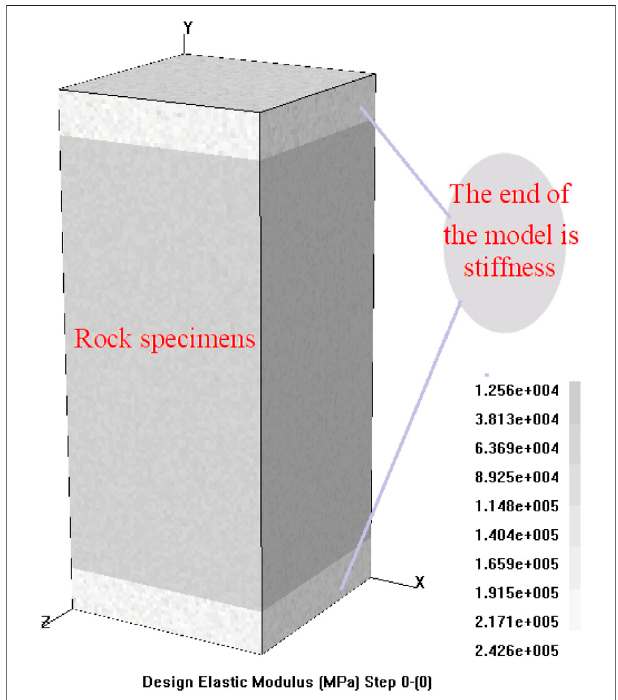
FIGURE 3 | Calculation model of the numerical